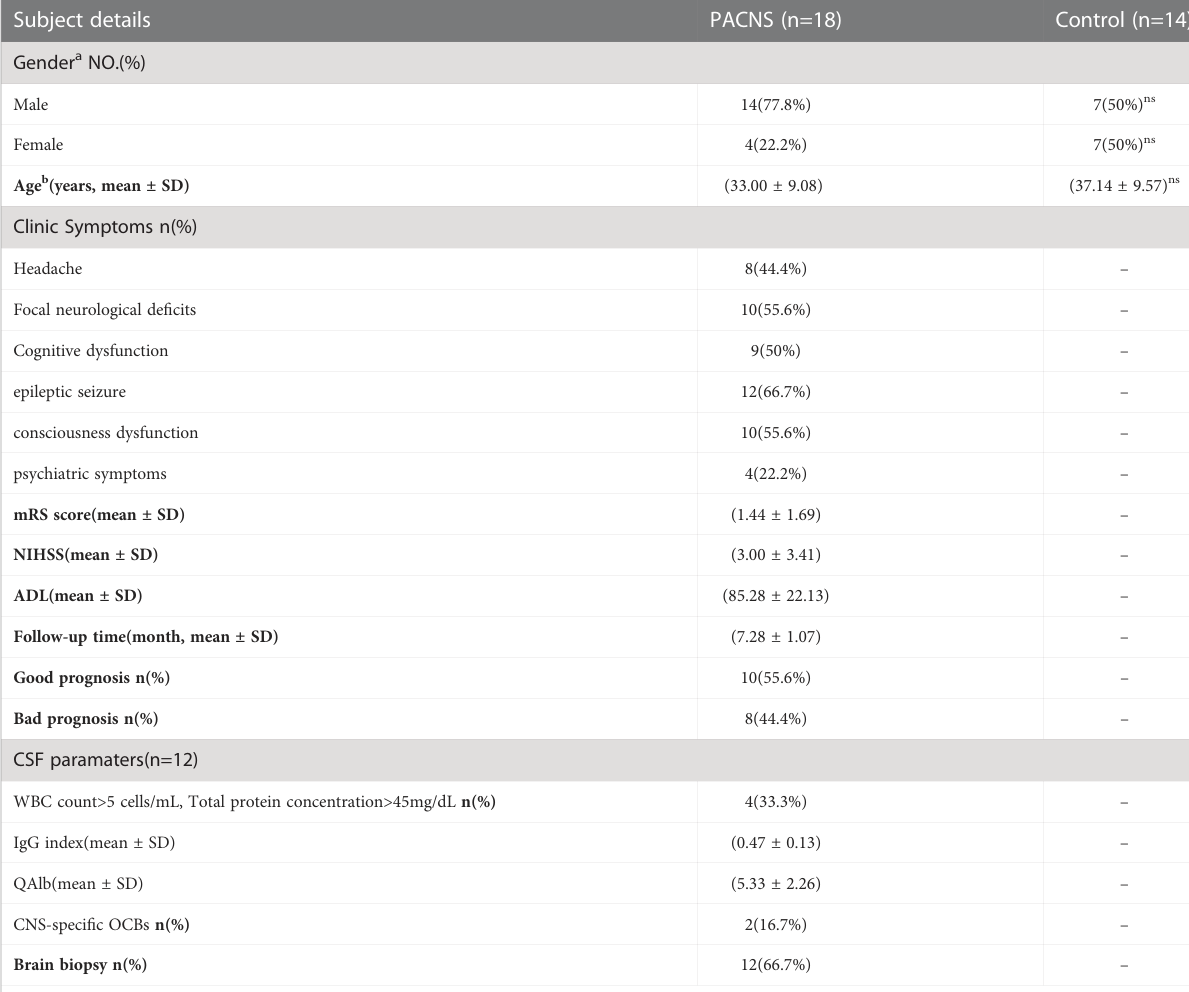
TABLE 1 Clinical and laboratorial data of patients in the PACNS and control